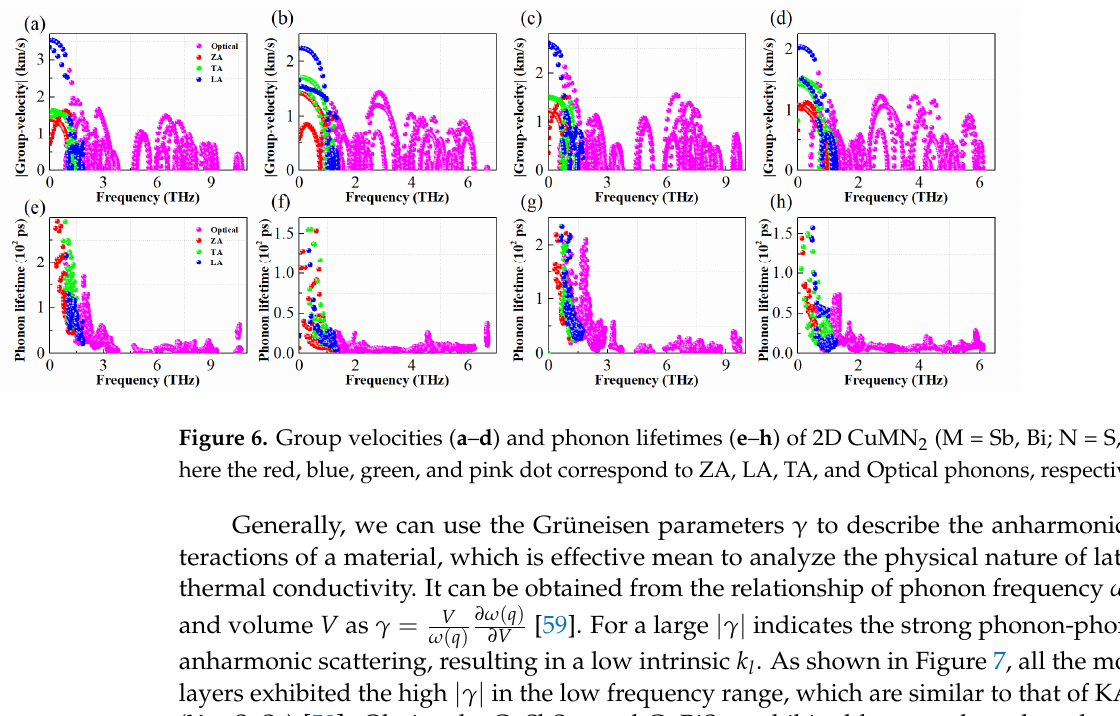
Figure 6. Group velocities ( a – d ) and phonon lifetimes ( e – h ) of 2D CuMN 2 (M = Sb, Bi; N = S, Se), Figure 7. The Grüneisen parameters γ for monolayer: ( a ) CuSbS 2 ; ( b ) CuSbSe 2 ; ( c ) CuBiS 2 ; and ( d ) here the red, blue, green, and pink dot correspond to ZA, LA, TA, and Optical phonons, respec- CuBiSe 2 . tively.